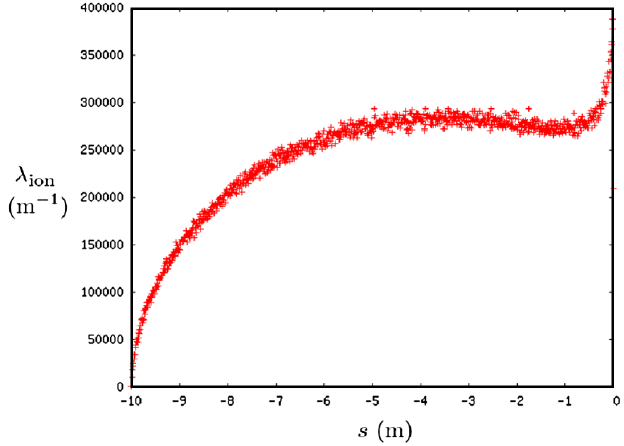
FIG. 3. (Color) Longitudinal ion distribution in the steady state for the 20 m beam